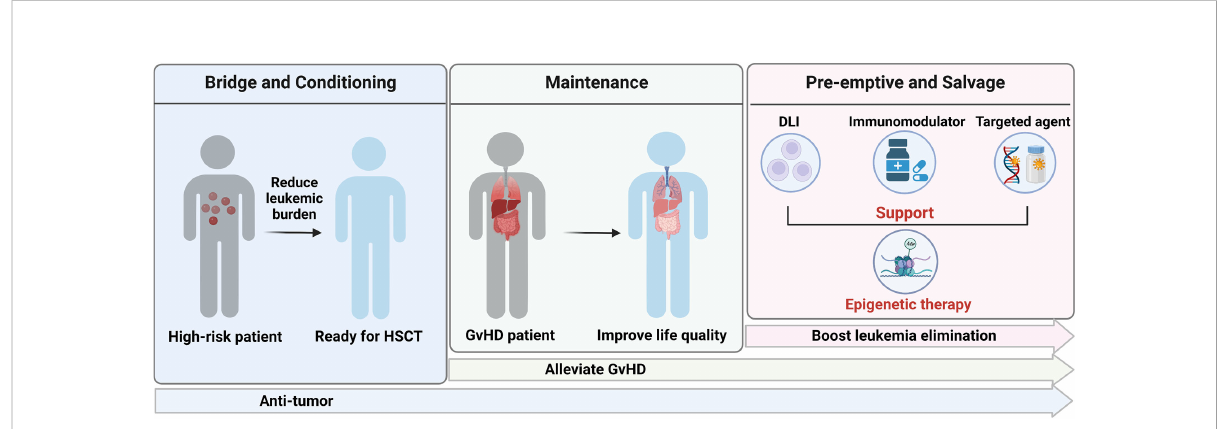
FIGURE 2 Application of epigenetic therapy in HSCT. Created with